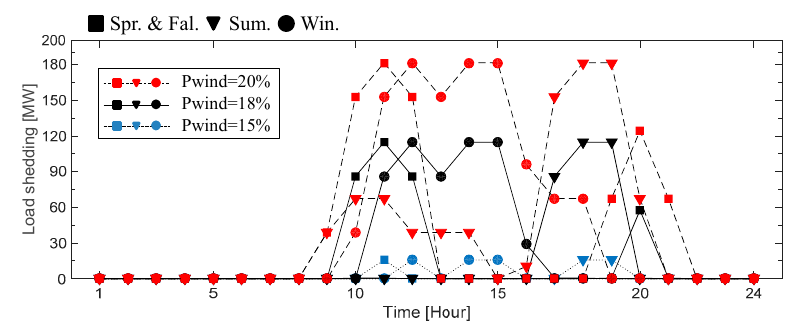
Figure 5. The time distribution of active power margin.